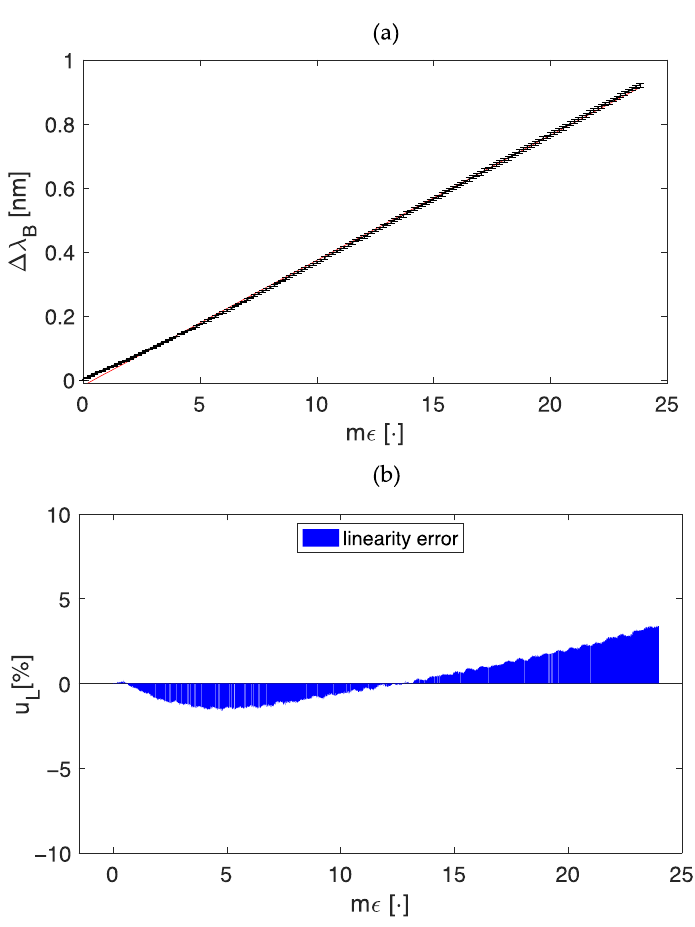
Figure 4. The calibration curve λ B vs. m ε ( a ), and the bar plot of the linearity error u L ( b ).